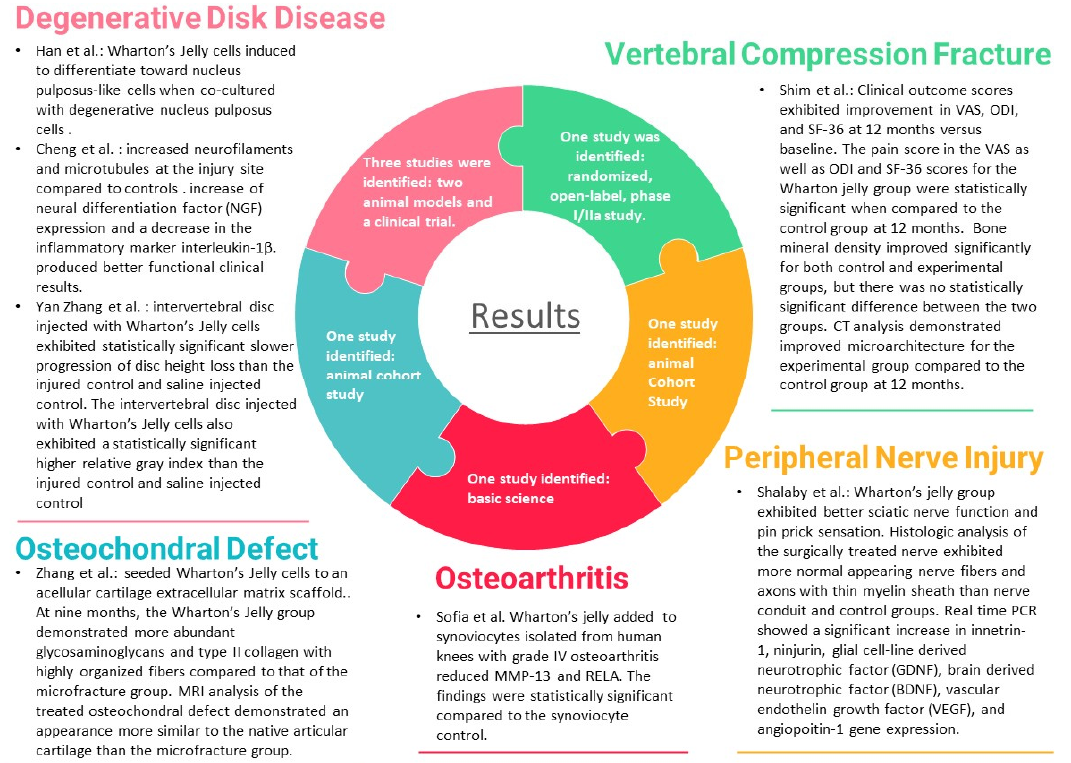
Figure 1. Summary of results of articles that met search criteria.